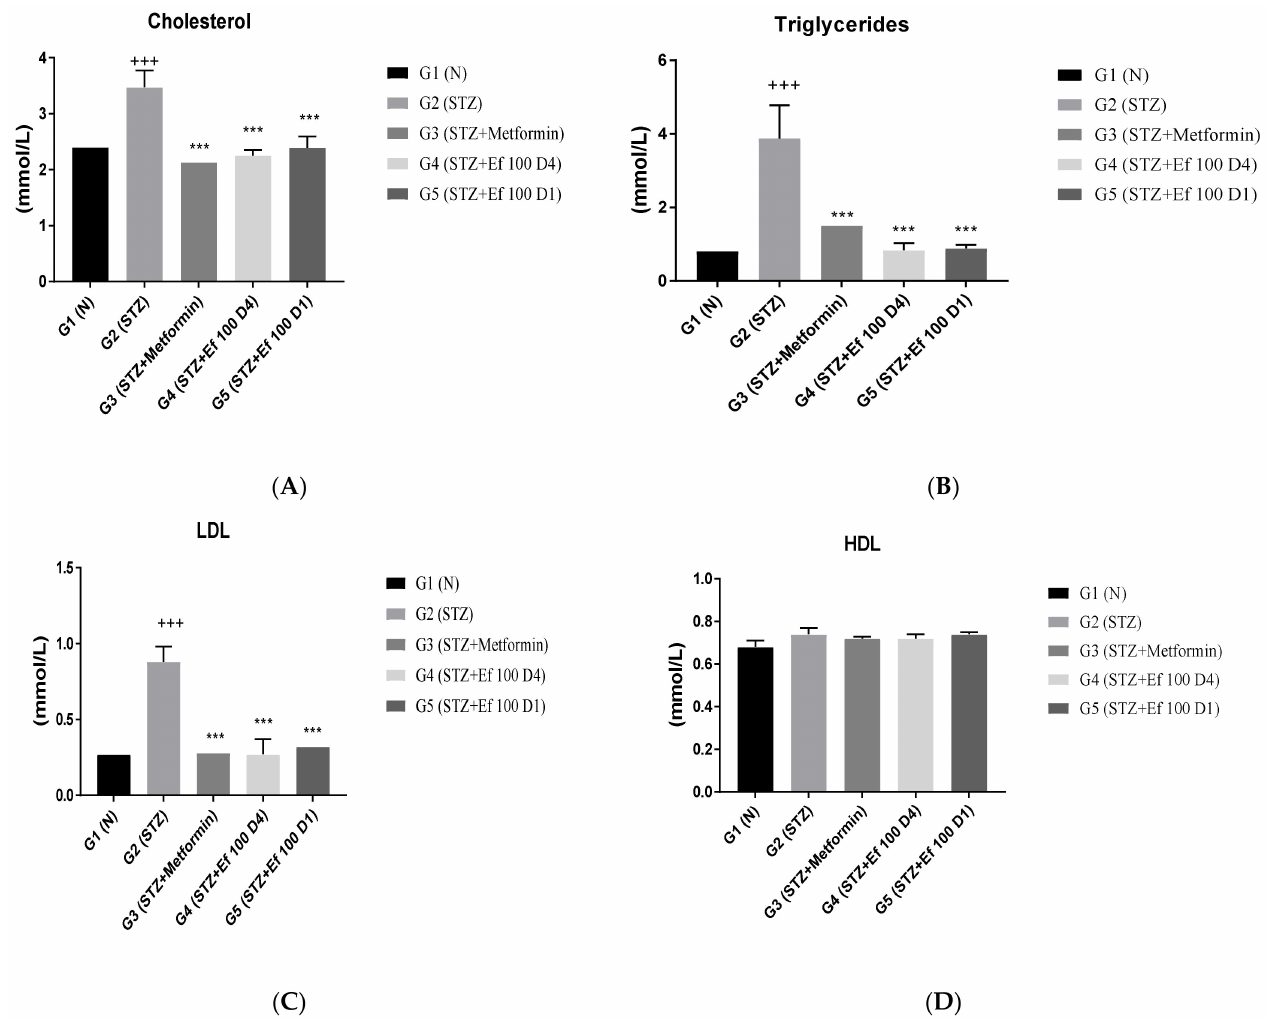
Figure 4. Effects of different treatments on serum lipid profiles in different groups. On Day 30, the concentrations of cholesterol ( A ), triglycerides ( B ), LDL ( C ), and HDL ( D ) were measured in all groups. Bars represent the mean of the parameters ± SD of 6 rats. Cholesterol, triglycerides, and LDL concentrations were significantly (*** p < 0.0001) lower in induced diabetic rats treated with metformin (G3) and Ephedra foeminea extract (G4 and G5) compared to the untreated induced diabetic rats (G2). The results are expressed as means ± SD ( n = 3–4 dependent replicates), ***: p < 0.001 compared to G2: diabetic rats. +++: p < 0.001 compared G1: nondiabetic rats. The result were analyzed using one way